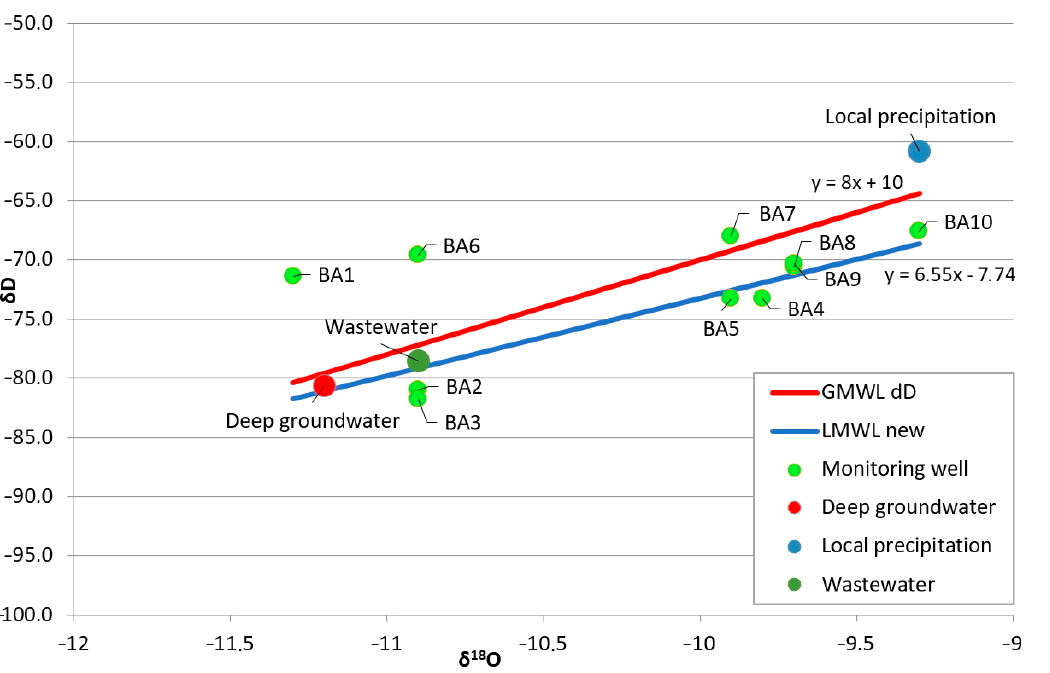
Figure 4. δ D and δ 18 O values of the monitoring wells in